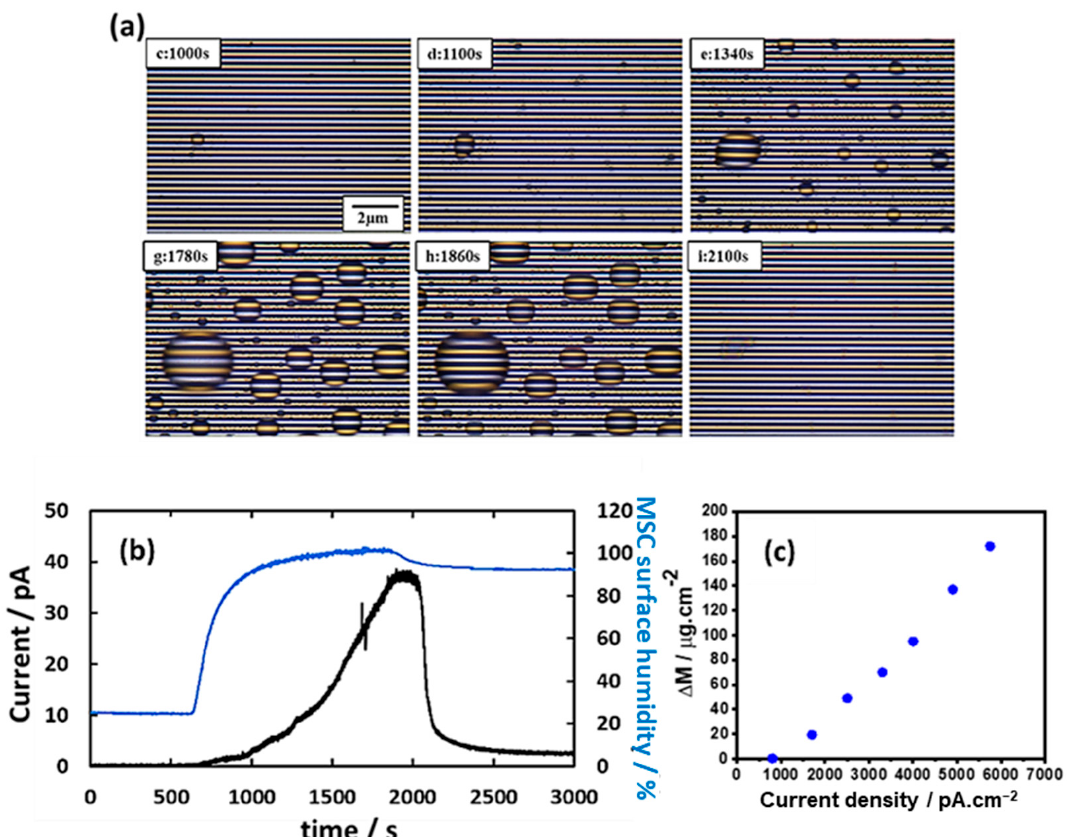
Figure 3. Detected frequency changes by QCM electrode ( a ) and detected response galvanic current by MSC ( b ) as a function of % RH. Linear correlation between mass per unit area and current density as a function of % RH ( c ). Linear correlation between current density and mass per unit area detected by QCM and MSC surfaces, respectively ( d ).